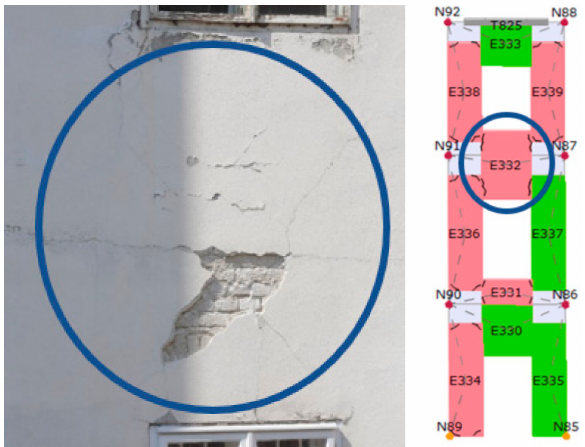
Figure 26. Comparison of the damaged spandrel (Southern façade).